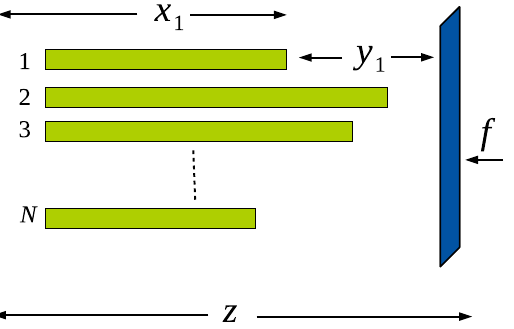
Figure 1. Schematic diagram for a bundle of inflexible filaments pushing against a movable rigid barrier acted upon by a constant force f . The rigid barrier also undergoes thermal motion characterised by diffusion coefficient D w